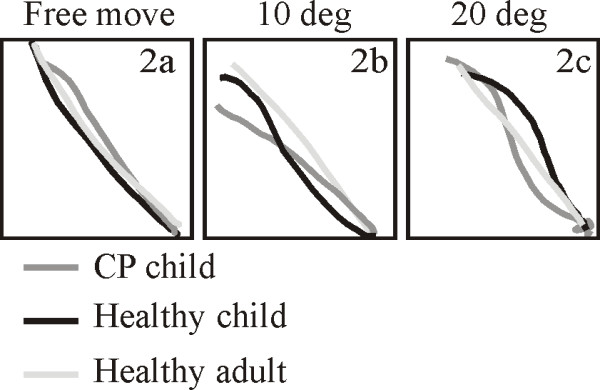
Single trial comparisons between the subject groups of the actual produced movement. The figure represent examples of individual drawings of the produced movement when the visual object is; free move, 10 and 20 deg manipulations when cued to the target in the upper left corner. The single trials within the CP group, is taken from an 8 and 9 year old CP child. The single trial examples of movements for the group of healthy children, is given by an 8 and a 12 year old healthy child.